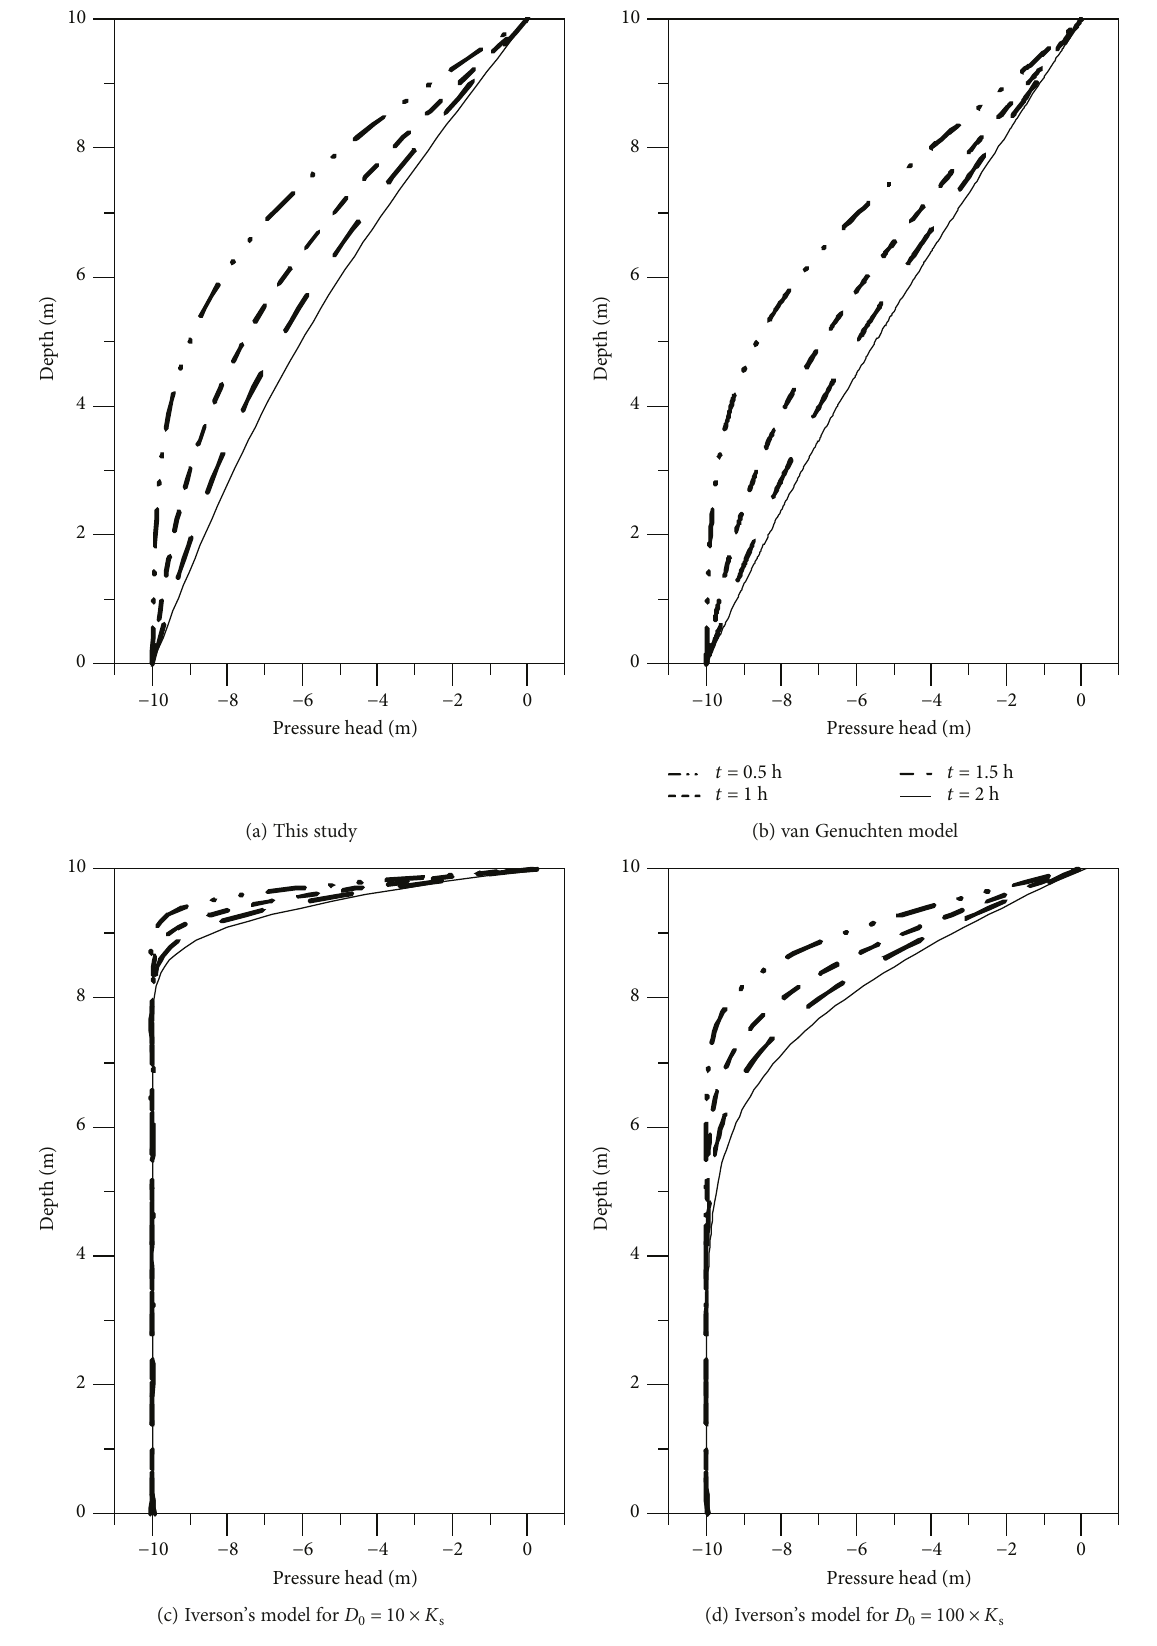
Figure 13: Comparison of computed pressure